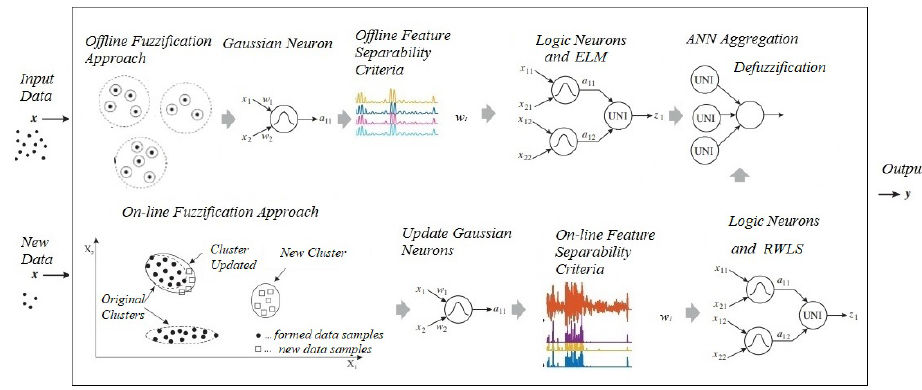
Figure 3. Algorithm execution steps. Algorithm 1 ENFS-Uni0-reg Training and Update